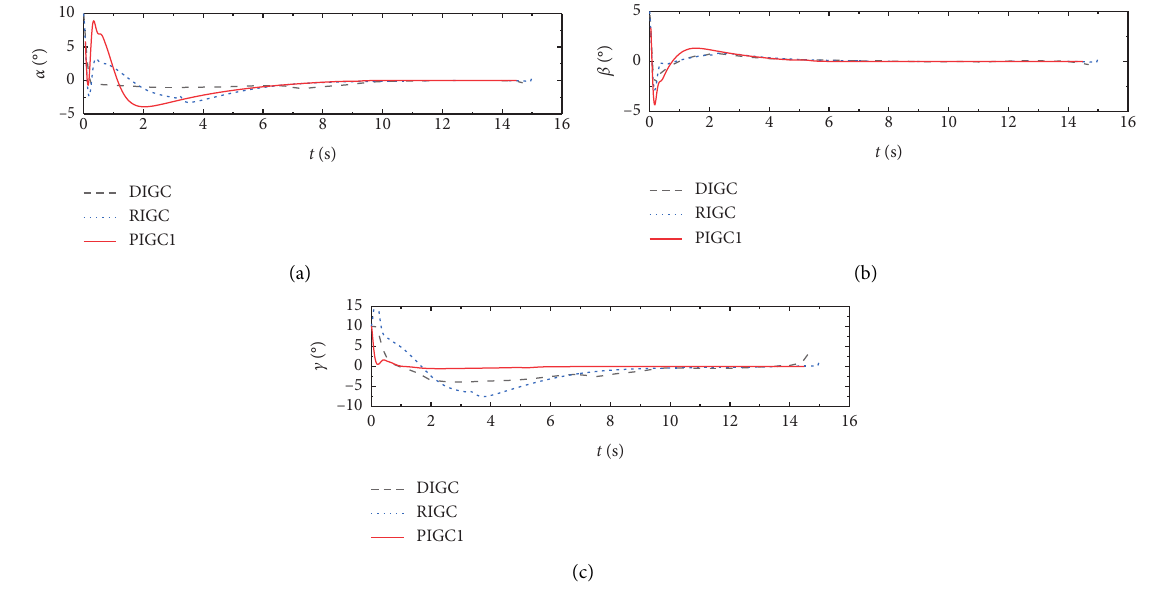
Figure 9: Curves representing attack, sideslip, and roll angles of Case